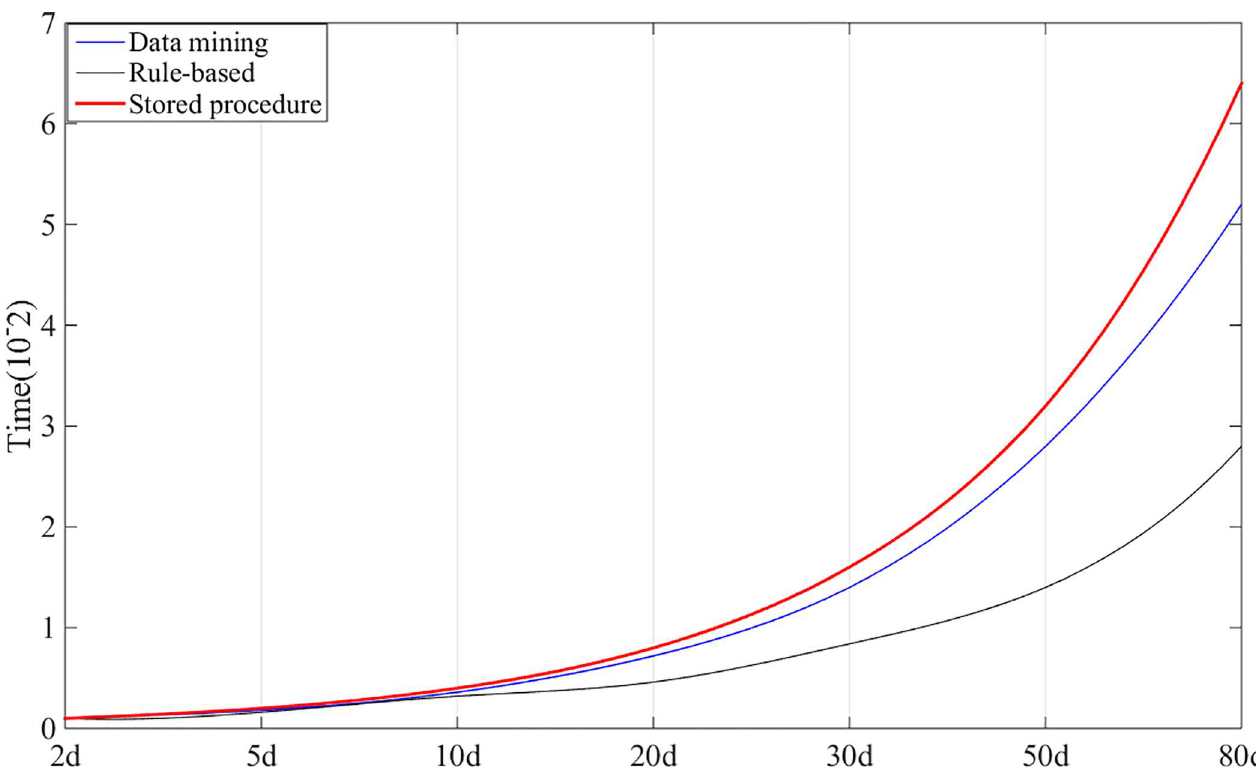
Fig 8. Test results of detection analysis